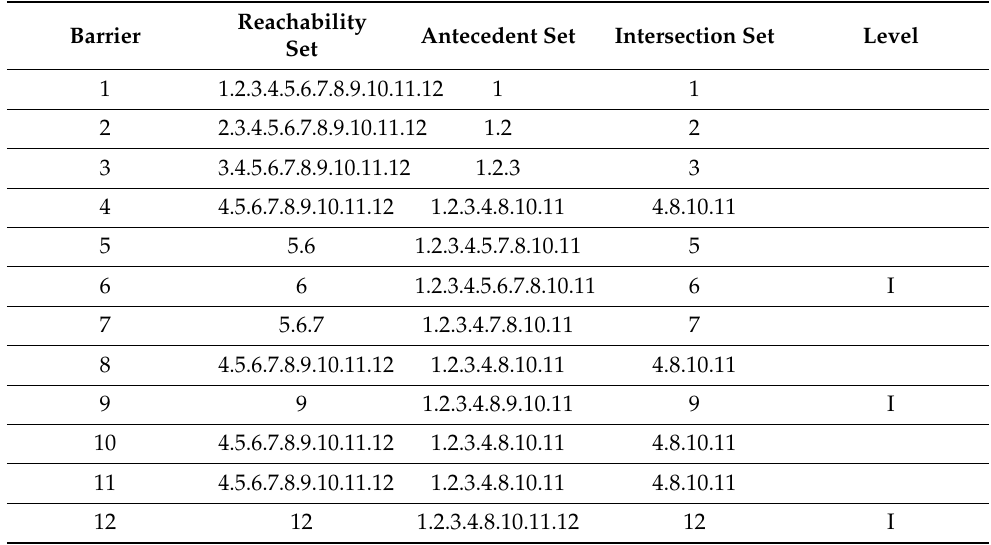
Table A4. Level Partitioning (Conventional Method)—1st